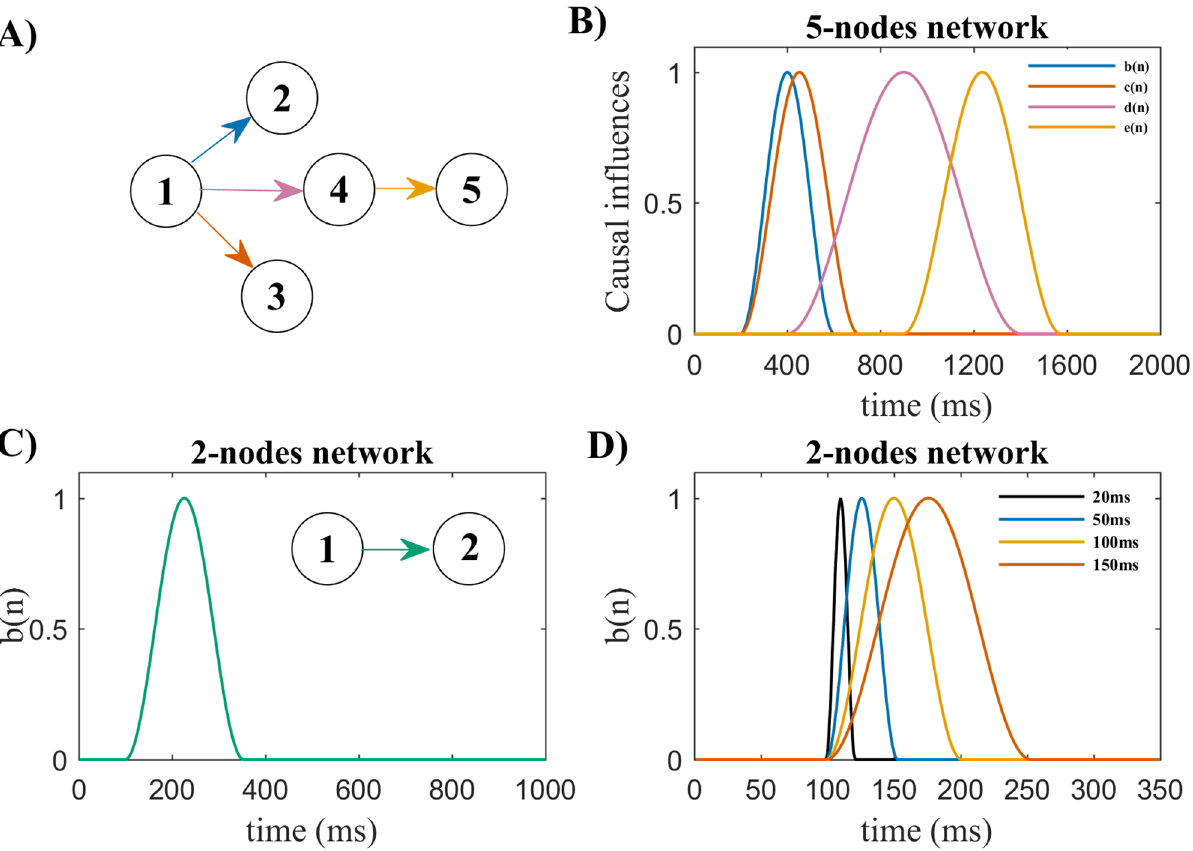
Fig 1. Simulated networks and time courses of the causal influences imposed. A) The diagram highlights the directed connections (arrows) imposed in the 5-nodes network, which was used for Simulation 1. All remaining possible connections between nodes are imposed to be constantly equal to zero. B) Shows the time-courses of the causal influences imposed in the 5-nodes network (Simulation 1), i.e. the dynamic evolution of the strength of each directed connection imposed in the model. Color coding matches the colors of the arrows shown in A). C) The diagram shows the directed connection imposed from node 1 to node 2 (green arrow) in the 2-nodes network and its time course in Simulation 2. This influence is active for a total duration in time of 250 ms. D) Alternative time courses of the causal influence from node 1 to node 2, with varying total durations, are considered for Simulation 3, which makes use of the 2-nodes